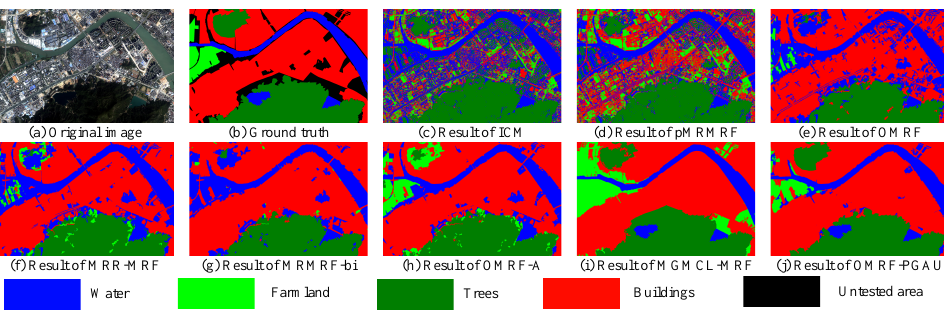
Figure 12. Semantic segmentation results for small size Gaofen-2